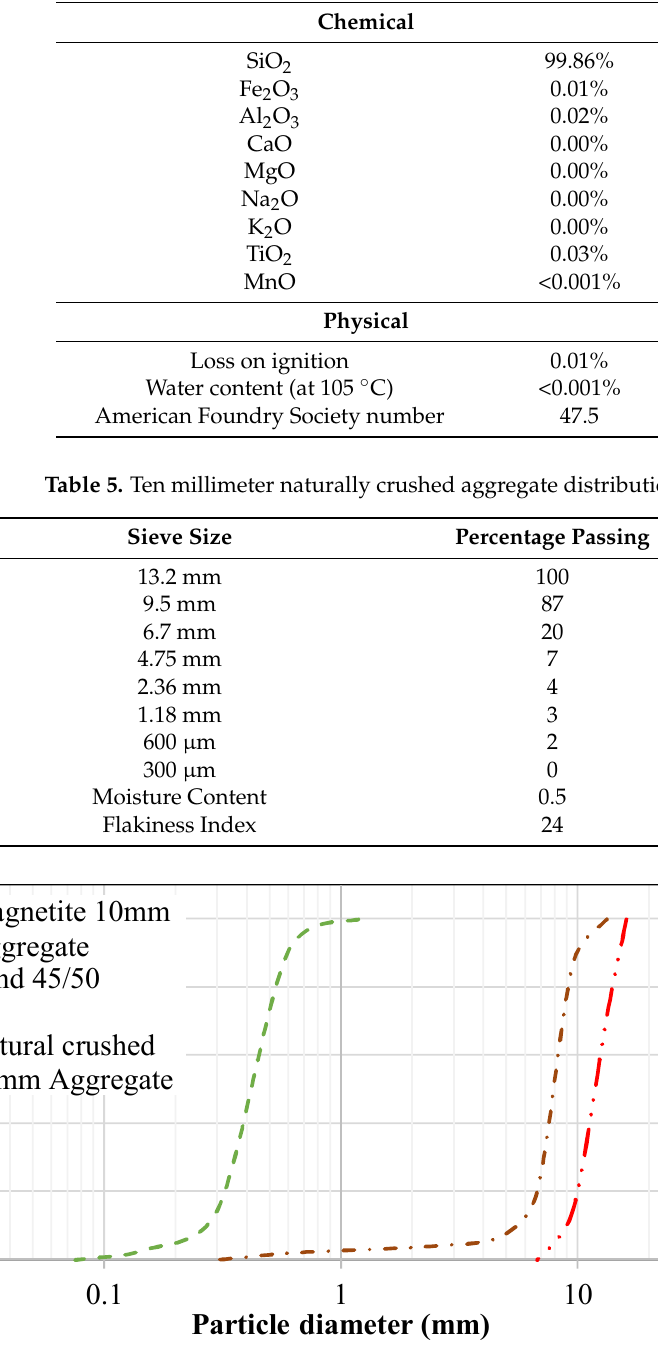
Figure 1. Grading curve of sand, 10 mm natural aggregate and 10 mm magnetite aggregate.